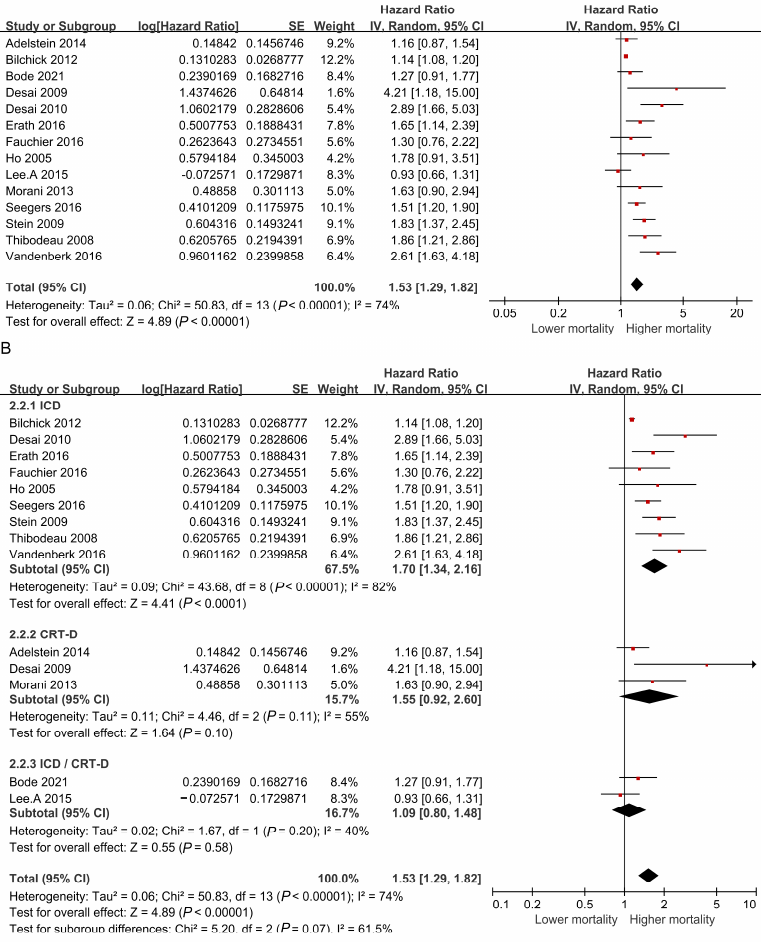
Figure 3. Pooled risk of all-cause mortality. Given the high heterogeneity, a random effects model was used. ( A ) Forest plot assessing all-cause mortality in recipients treated with digitalis. The studies